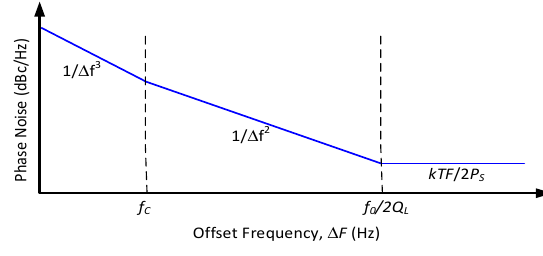
Figure 24. Typical phase noise power spectral density (single sided).